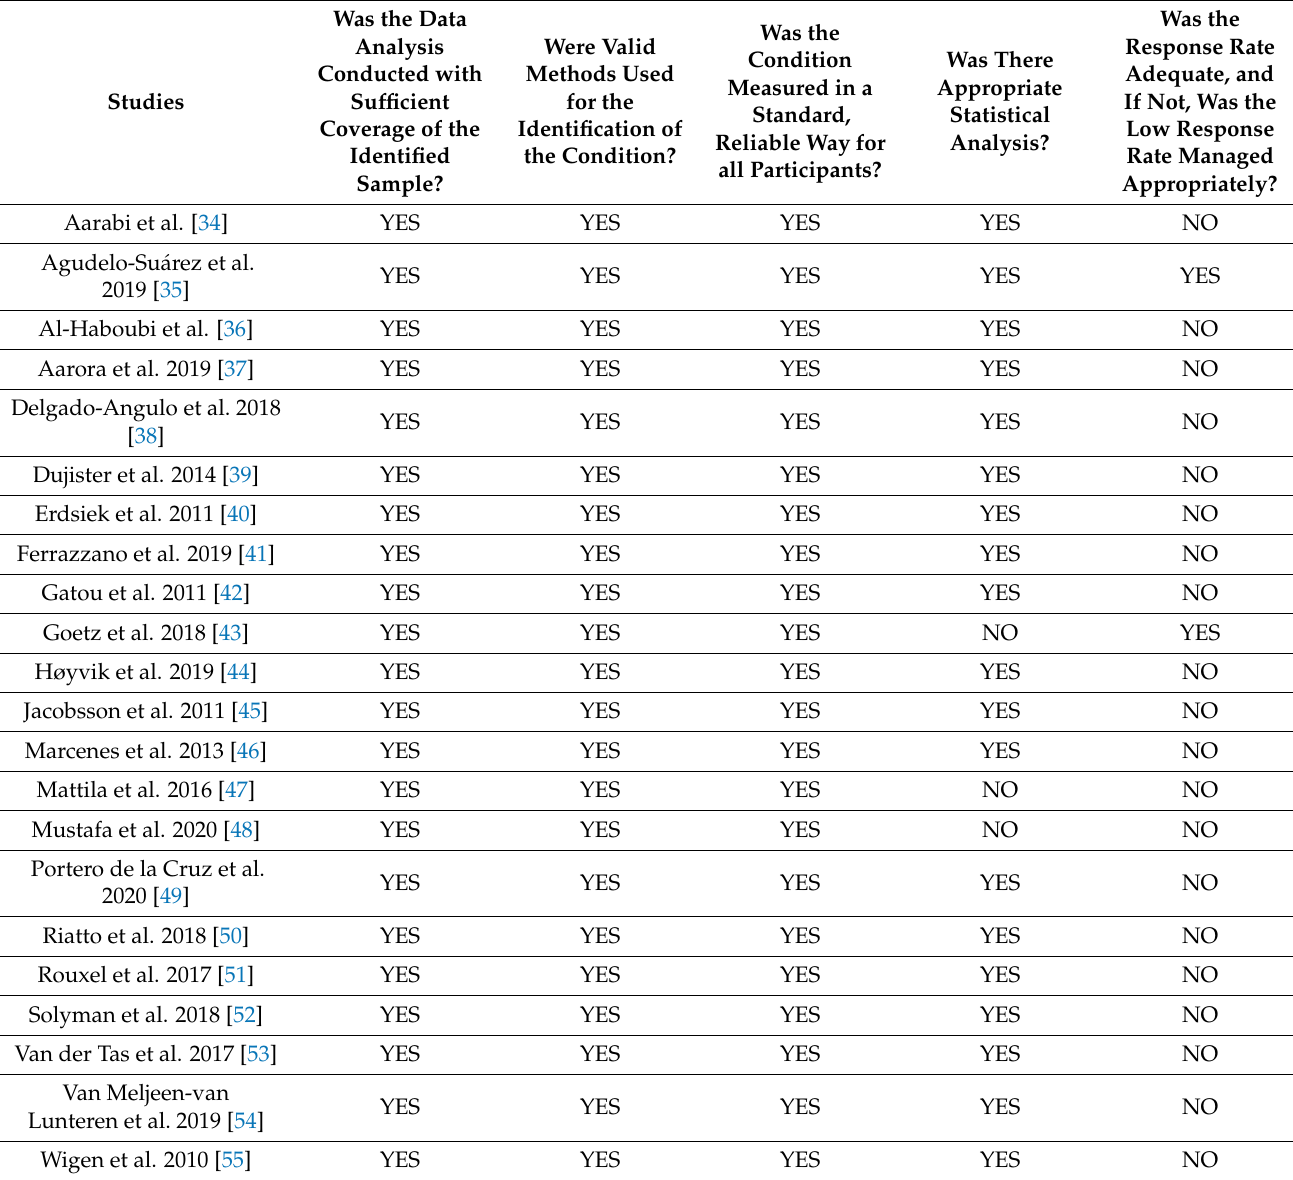
Table 2. JBI for cross-sectional studies: diagnosis, data analysis, response rate.